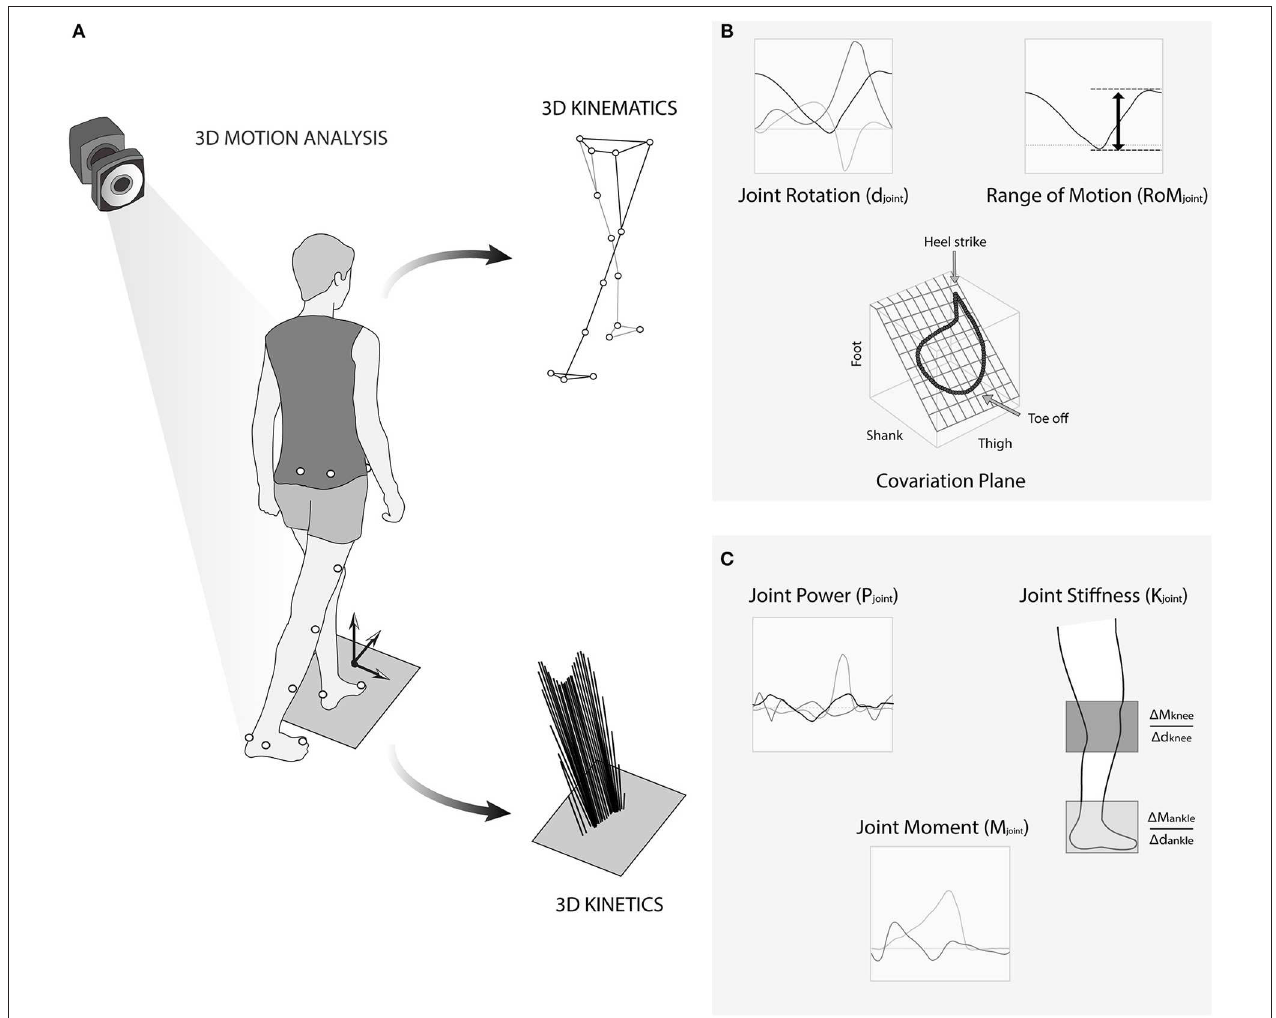
FIGURE 1 | (A) Representation of the 3D recording of locomotion with the marker set, with the extracted markers trajectories (Top), and the recorded ground reaction forces (Bottom). (B) Details of the joint rotation, joint range of motion, and covariation plane. (C) Details of joint power and moment for computing stiffness.